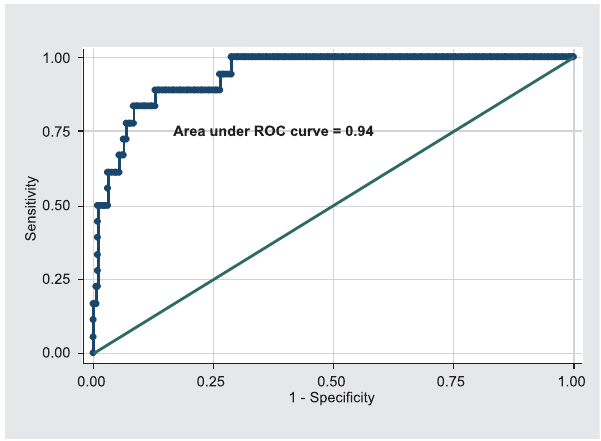
Figure 3. Receiver operating characteristic (ROC) curve of the multivariate logistic regression model for leptospirosis vs. dengue (Table 4). Diagonal line represents the null hypothesis.